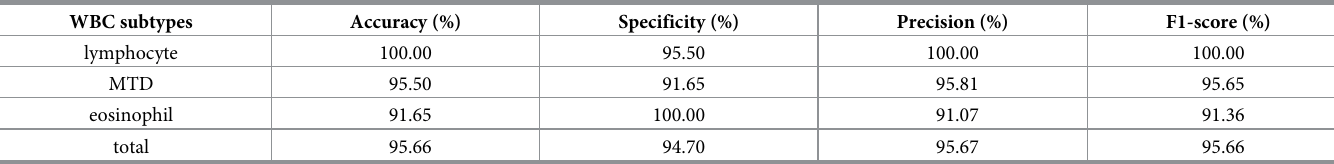
Table 4. Training results when epoch = 20 and batch size = 32.